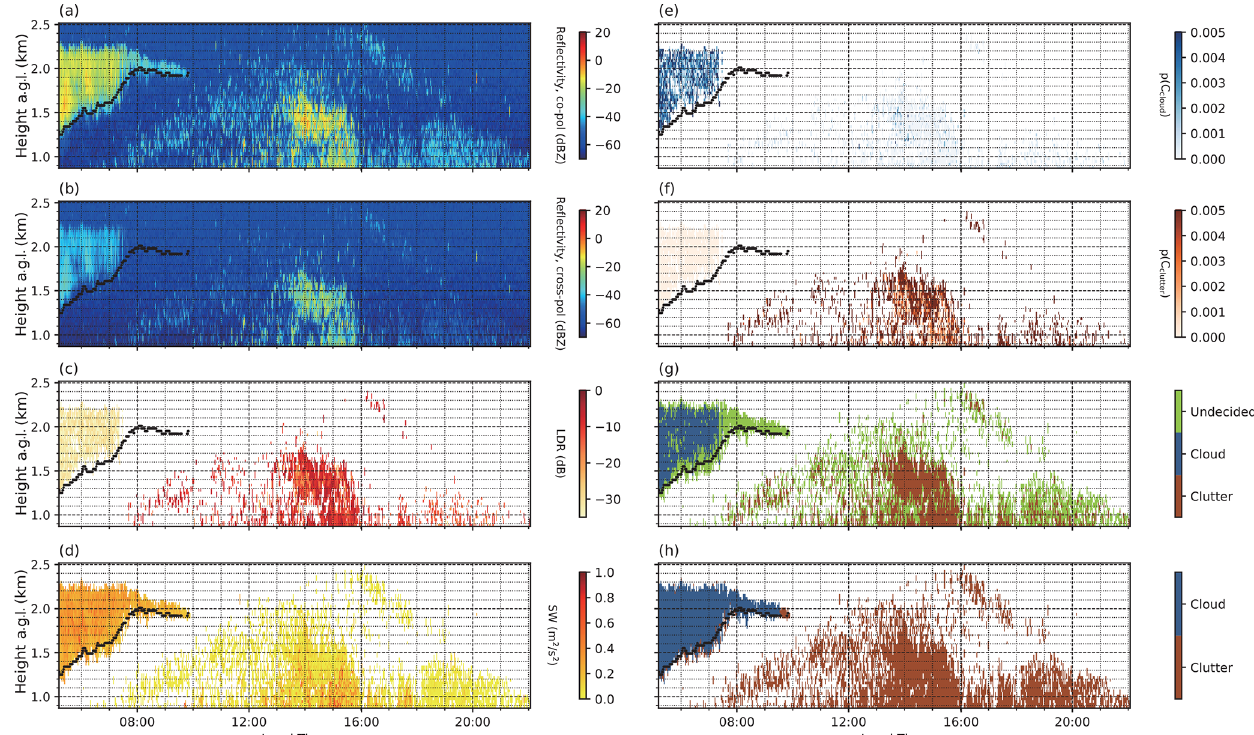
Figure 7. (a) Reflectivity of co-polarized (co-pol), (b) reflectivity of cross-polarized (cross-pol), (c) LDR, (d) SW, (e) estimated probability of cloud, (f) estimated probability of clutter, (g) classification mask using the Bayesian method, and (h) classification mask after the spatial filter from 05:00 to 22:00LT on 24 September 2013. The black dots represent lidar-detected cloud base